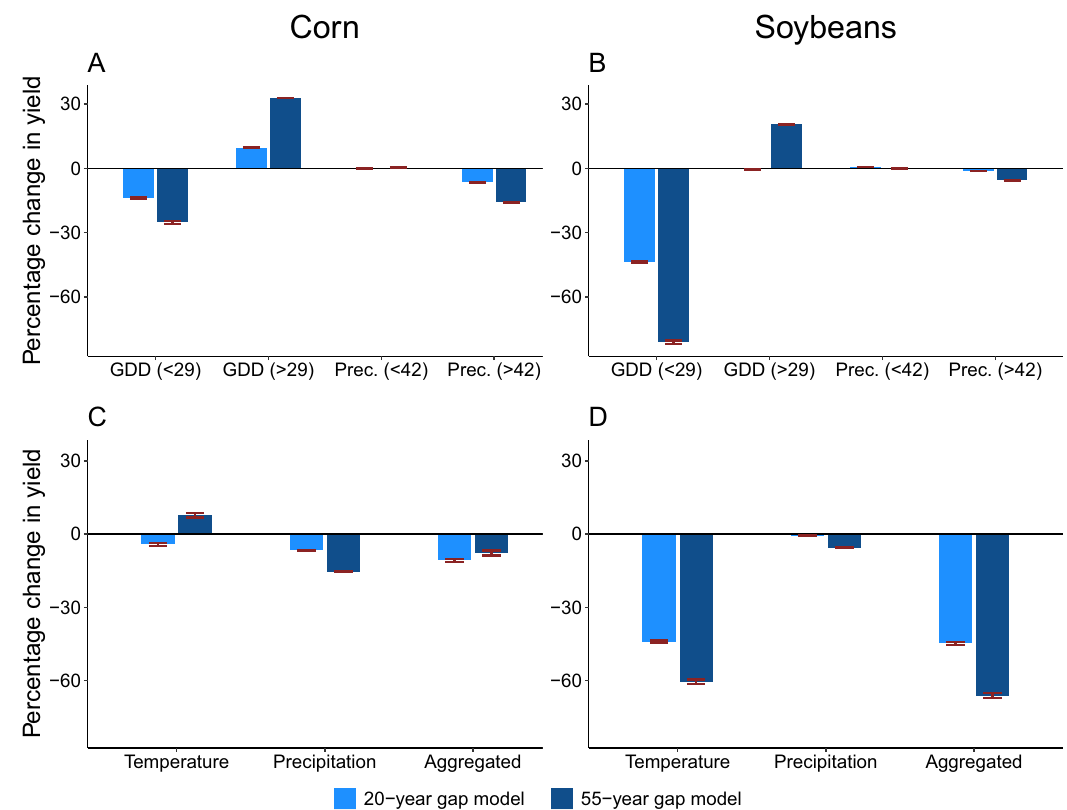
Figure 3. Partial and aggregated adaptation or maladaptation to climate change. Notes : GDD (< 29) represents the GDD between 0 and 29 °C and GDD (> 29) represents the GDD above 29 °C. Prec. (< 42) and Prec. (> 42) represent the precipitation below and above 42 cm, respectively. The daily climatic variables are aggregated to the growing season level, where the growing season is defined as April 1 to September 30 in a year. Graphs A and C are for corn yield and Graphs B and D are for soybean yield. The 20-year gap model uses 1978–1982 as the first period and 1998–2002 as the second period. The 55-year gap model uses 1958–1962 as the first period and 2013–2017 as the second period. The length of a bar shows the weighted average of all county-level partial or aggregated adaptation to the corresponding climate variables. It represents difference between the crop yields with and without adaption (e.g., the length of BC in Fig. 1) divided by the initial crop yield (e.g., V 0 in Fig. 1). The negative values indicate maladaptation. The whiskers are 95% confidence intervals of the estimates. Values for Prec. (< 42) are close to 0. See Supplementary Table S5 for specific numerical values. To convert the change in x − 1 ) × 100% log yield (say, x ) to the percentage change in yield, we use the formula ( e . Similar calculations are used for Figs. 4, 5, and Supplementary Fig.